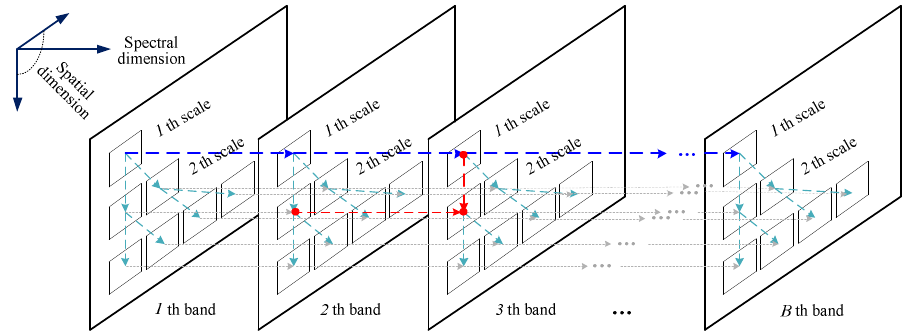
Figure 6. Illustration of NSST high-frequency subbands spatial spectral dimensional forest construc- tion.